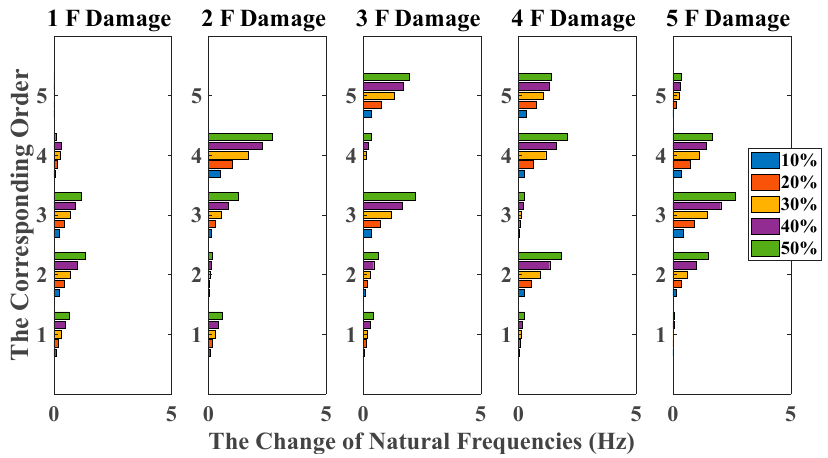
Figure 7. Damage detection results based on the change of natural frequencies (El Centro earthquake excitation, 5% noise, data length = 4000).